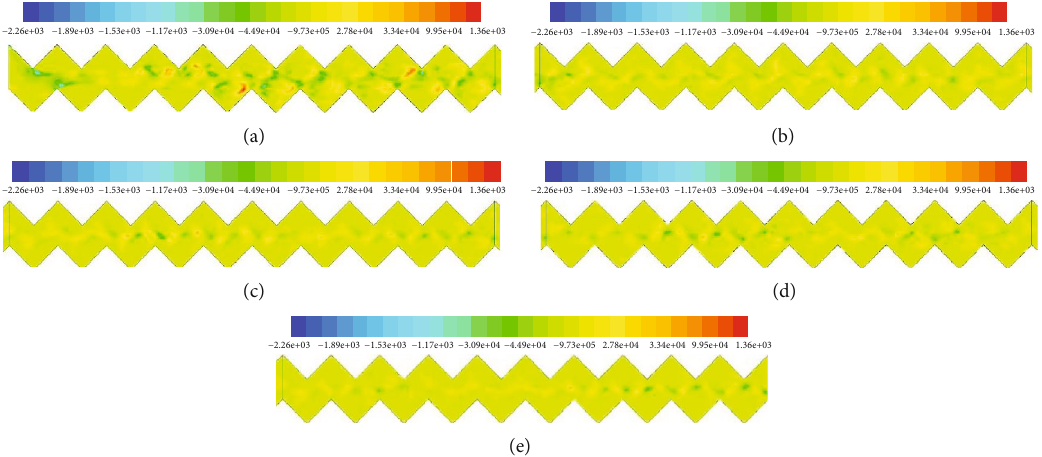
X = 0 mm to X = 20 mm ; (b) 1 1 = 80mm to X = 100 mm . 1 1